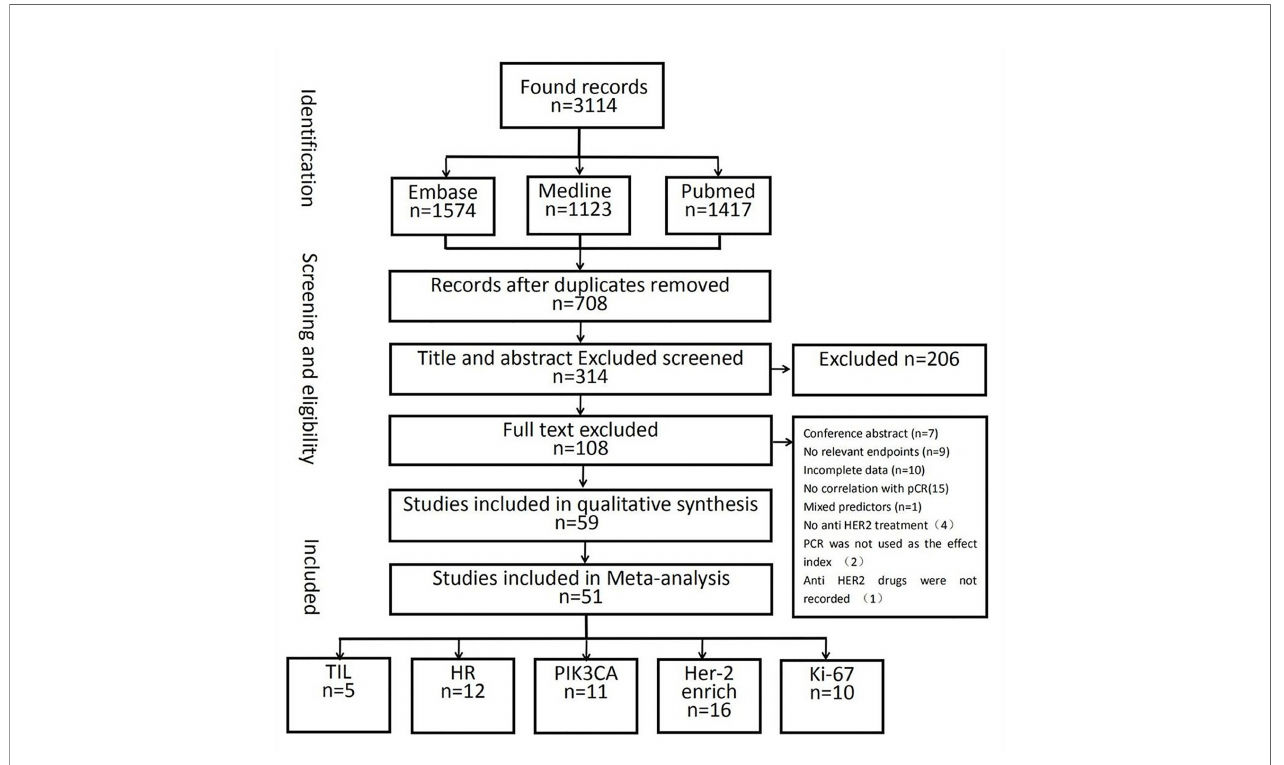
FIGURE 1 | Flowchart illustrating the study-selection